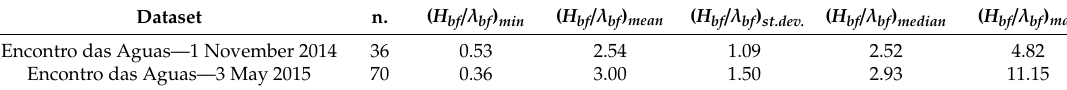
Table 9. Dune steepness H bf / λ bf (multiplied by 100). Legend: ( H bf / λ bf ) min = minimum wave steepness; ( H bf / λ bf ) mean = mean of the wave steepness; ( H bf / λ bf ) st.dev. = standard deviation of the wave steepness; ( H bf / λ bf ) median = median of the wave steepness; ( H bf / λ bf ) max = maximum wave steepness.